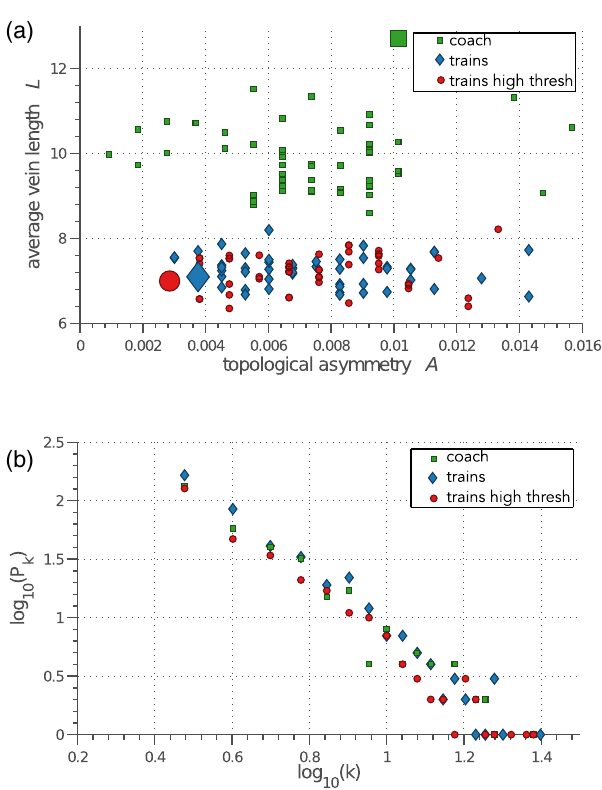
FIG. 15. (a) Average vein length L versus topological asym- metry A for the coach network (large green square), and the low- and high-threshold train one (large blue diamond and red circle, respectively). The small symbols represent networks with the same underlying topology as the coach network (small green squares), and the low- and high-threshold train one (small blue diamond and small red circle, respectively), but randomized edge weights. (b) Degree distribution of the topologies of the coach and train networks. The numbers of nodes P of degree k can be k approximated by a power